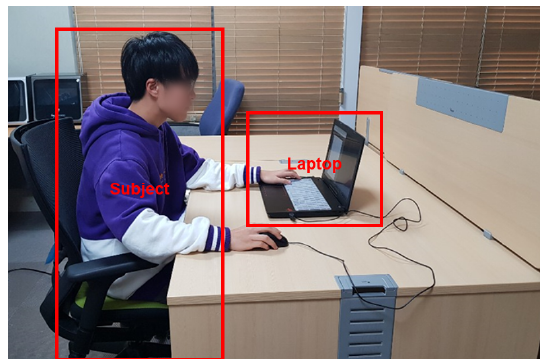
Figure 2. Setup of the experiment in a closed room. A subject proceeds with the experiment with a laptop computer. There was not only no one else except the subject, but also no camera not to make the subject nervous or